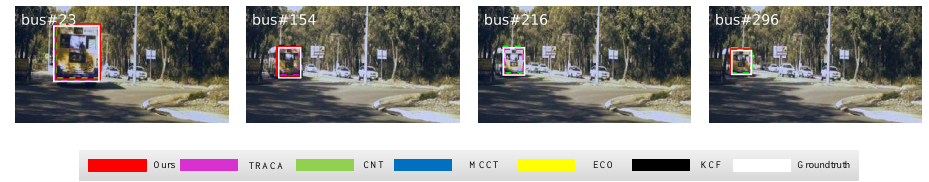
Figure 21. Qualitative results on the ball sequence in color.